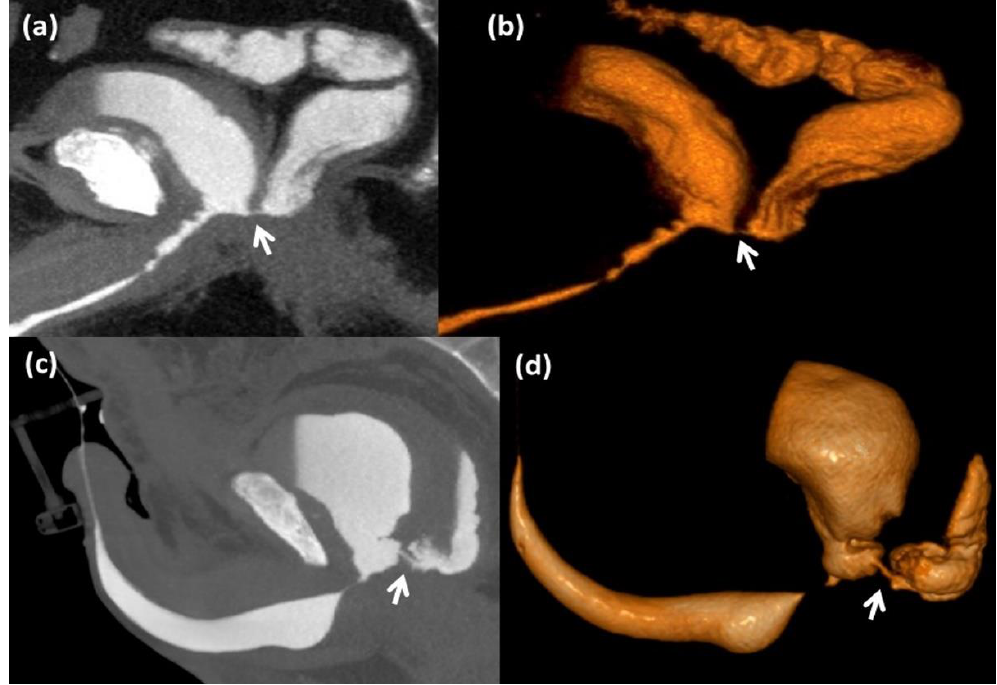
Figure 5. Fine-caliber periurethral fistulas visualized only by CT-retrograde urethrography: ( a ) CT-RUG showing small- caliber vesicorectal fistula (arrow); ( b ) 3D CT-RUG image of the same case as A; ( c ) CT-RUG showing fistulous tract between neocavity of the posterior urethra and rectosigmoid (arrow); ( d ) 3D CT-RUG image of the same case as C.